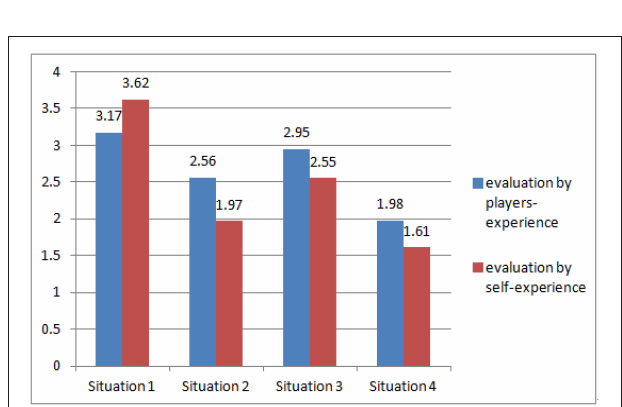
FIGURE 3 | The effectiveness of evaluation by situation and evaluation by